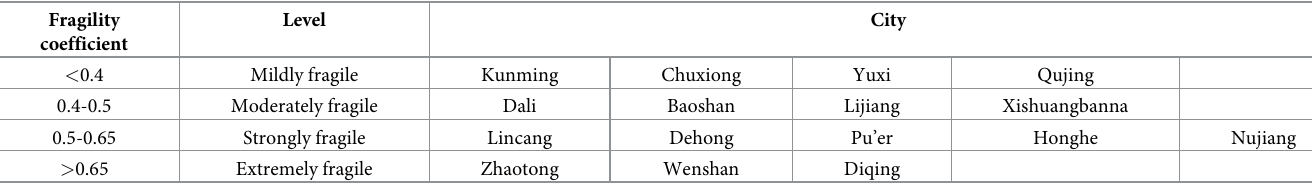
Table 3. Ecological environmental fragility levels in Yunnan Province. Fragility coefficient